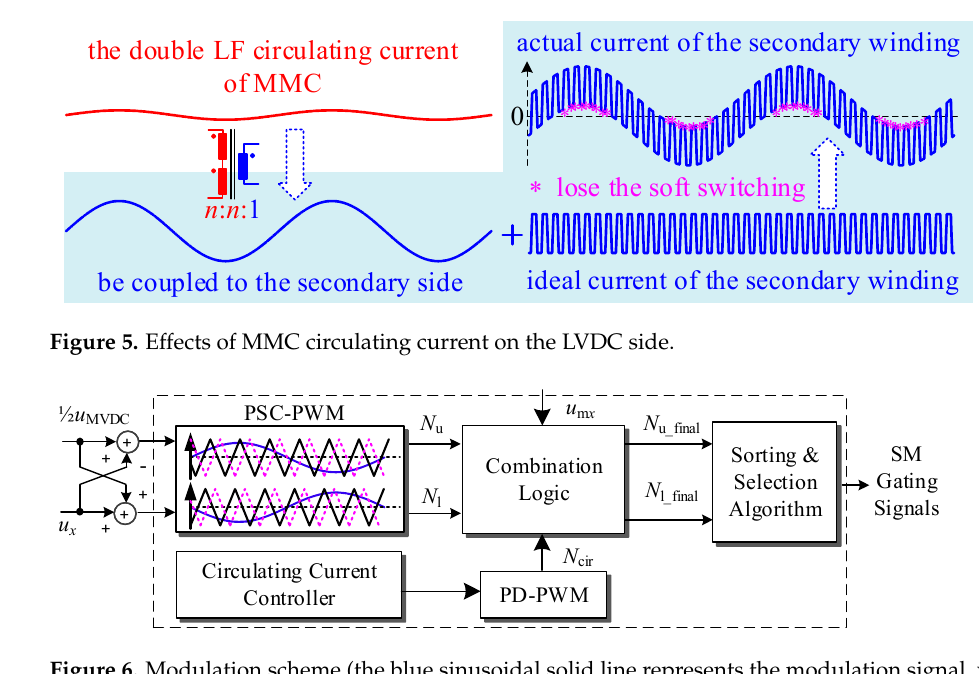
Table 1. Parameters of proposed PET.